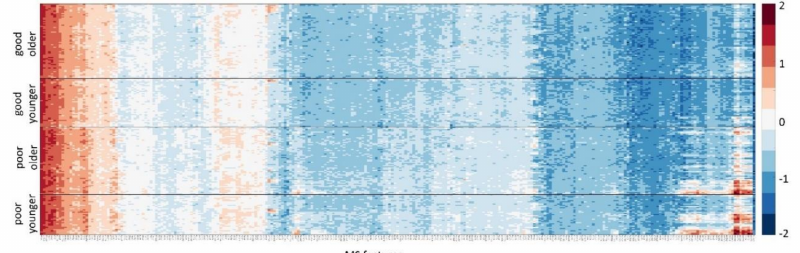
Figure 1. Heatmap of the natural logarithm of features used in the test. Samples in the development cohort are shown as rows, grouped by test classification (good or poor) and age category (younger (age ≤ 55) and older (age ≥ 56)). Mass spectral features are shown as columns. Features and samples are hierarchically clustered.